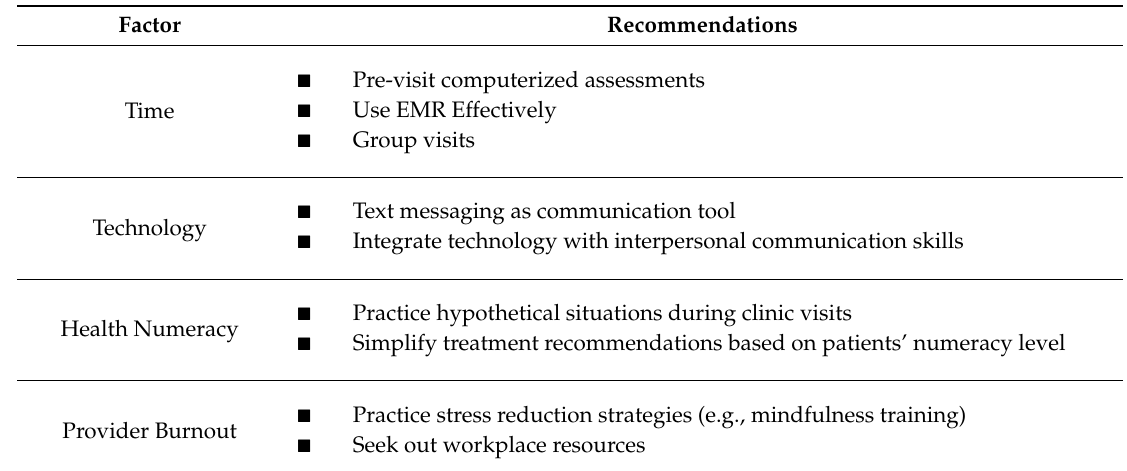
Table 1. Essential Factors for Improving